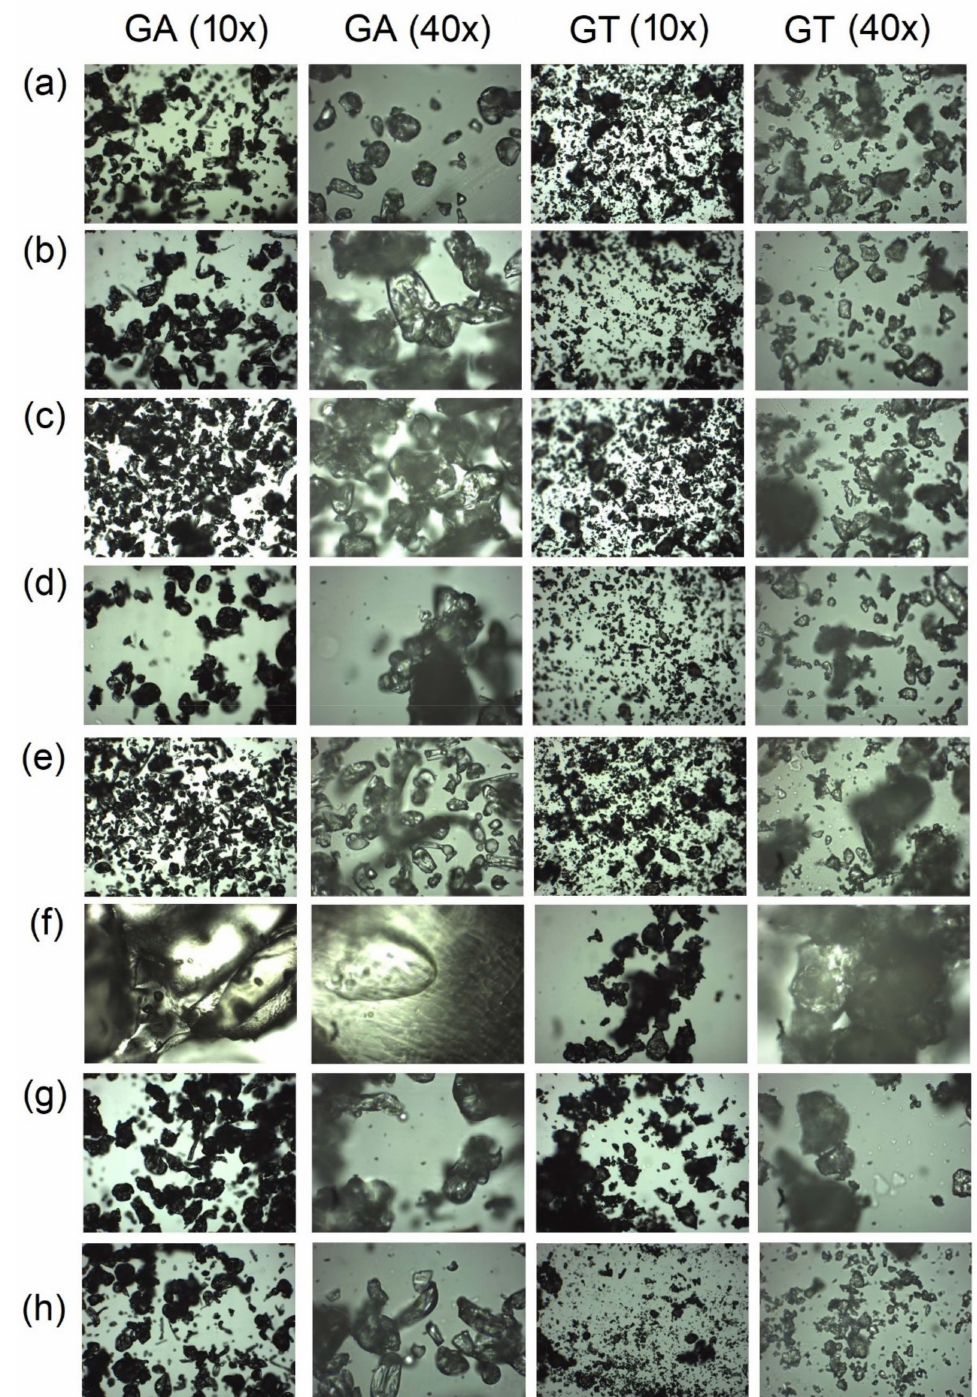
Figure 6. Optical microscopy images of ( a ) gum arabic (GA) and gum tragacanth (GT) stored in a closed package (initial samples). GA and GT stored in room conditions (25 ◦ C, 45%RH) in open package for ( b ) 3 days and ( c ) 2 months. GA and GT stored in under conditions of accelerated aging (40 ◦ C, 65%RH) in the open package for ( d ) 3 and ( e ) 6 days. ( f ) GA and GT stored in room temperature, and in increased relative humidity (25 ◦ C, 75%RH) in open package for 3 days. ( g ) GA and GT UV-irradiated during 120 min. ( h ) GA and GT storage in temperature 80 ◦ C for 60